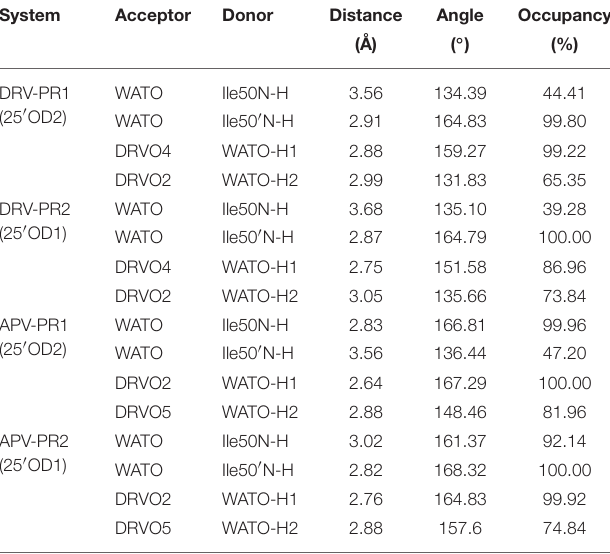
TABLE 5 | Occupancy of hydrogen bonds of bridging water during MD simulation. System Acceptor